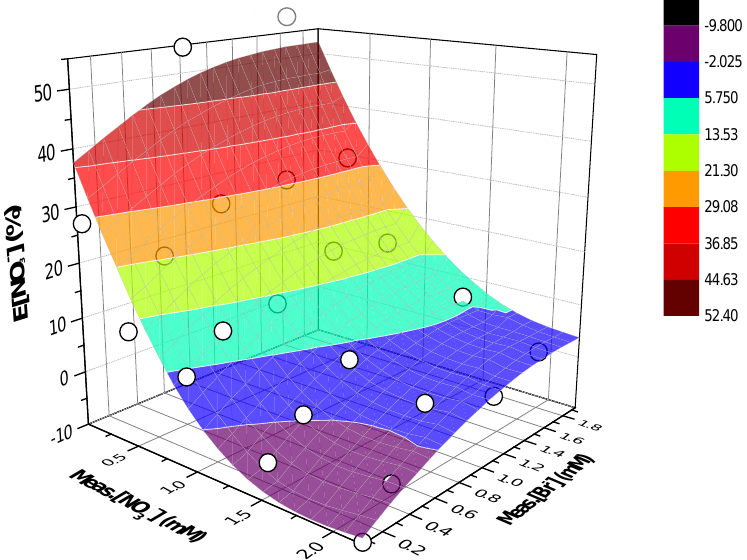
Figure 6. 3D surface fitting the experimental data (white points) as triads (x, y, z) = (Meas.[NO 3 − ], Meas.[Br − ], E[NO 3 − ]). Eluent 1 mM NaHCO 3 –3.2 mM Na 2 CO 3 . Integration of the peaks as shown in Figure 1.